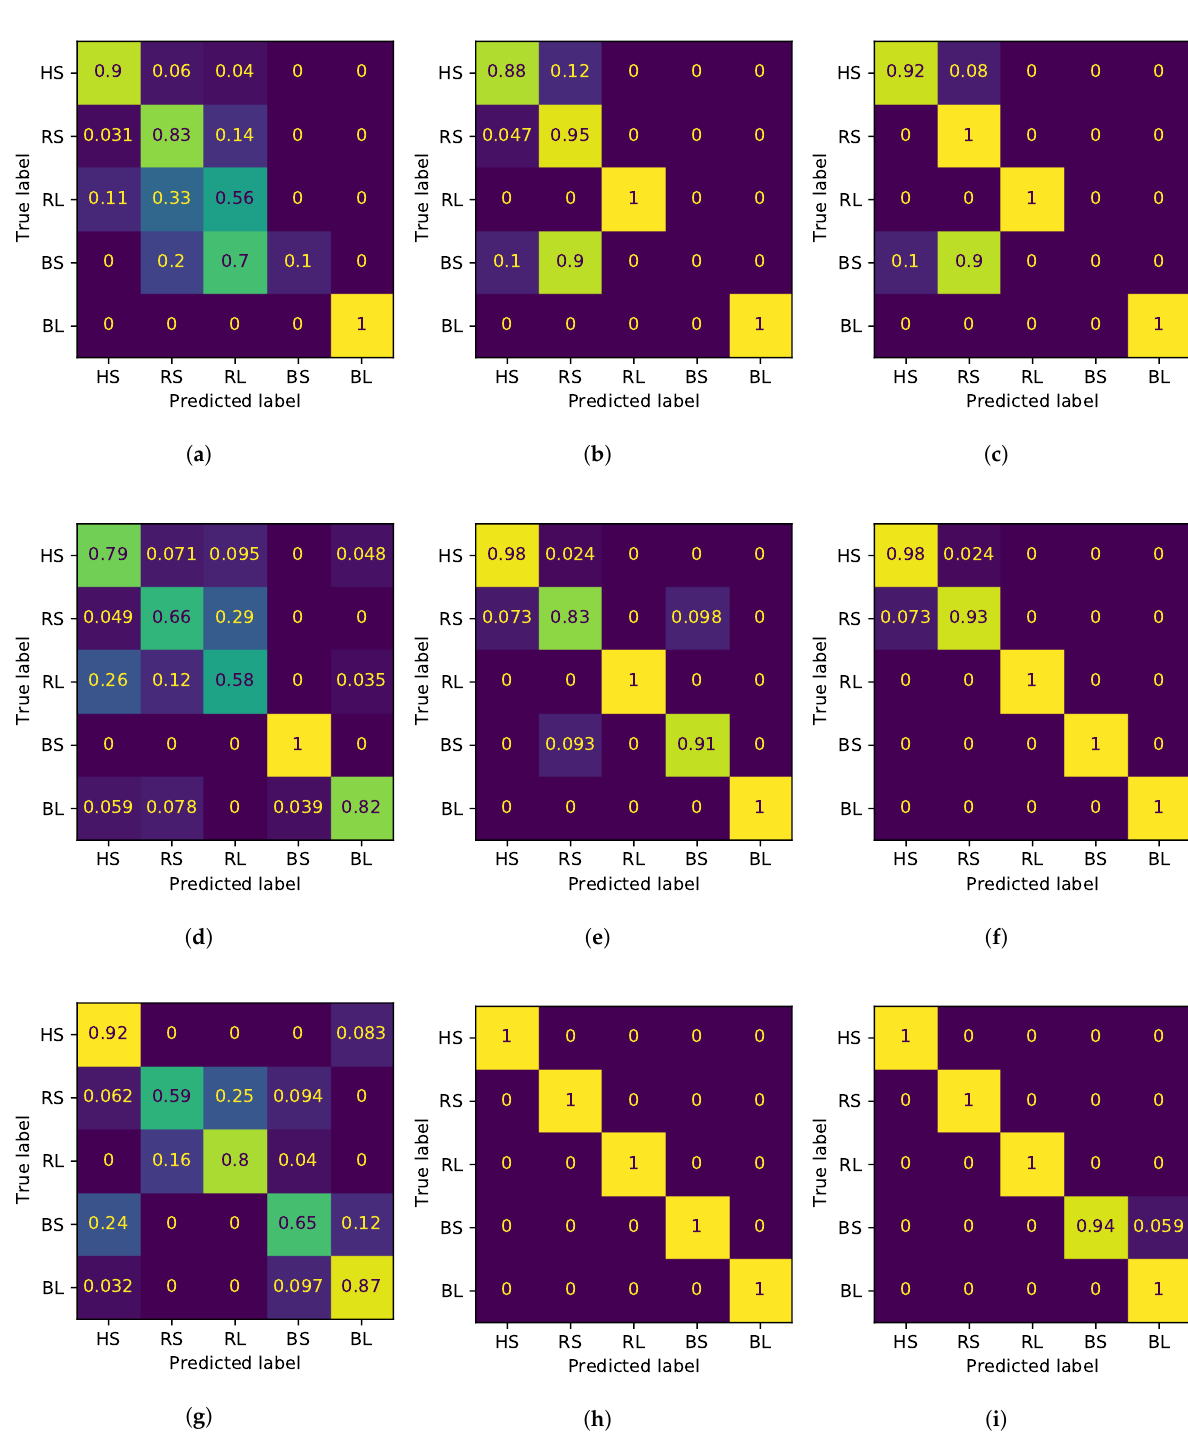
Figure 13. Confusion matrices for the diagnosis of low-speed bearings using random forest classifier, varying the indicator type and the rotational speed of the data. The results were normalized over the true labels. The first row shows the results at 10 rpm, the second row at 8 rpm, and the last row at 5 rpm. The first column shows the results for classic indicators (CIs), second column for entropy indicators (EIs), and the last column shows the classic and entropy indicators (CEIs). ( a ) Confusion matrix for CIs and data at 10 rpm. ( b ) Confusion matrix for EIs and data at 10 rpm. ( c ) Confusion matrix for CEIs with data at 10 rpm. ( d ) Confusion matrix for CIs and data at 8 rpm. ( e ) Confusion matrix for EIs and data at 8 rpm. ( f ) Confusion matrix for CEIs and data at 8 rpm. ( g ) Confusion matrix for CIs and data at 5 rpm. ( h ) Confusion matrix for EIs and data at 5 rpm. ( i ) Confusion matrix for CEIs and data at 5